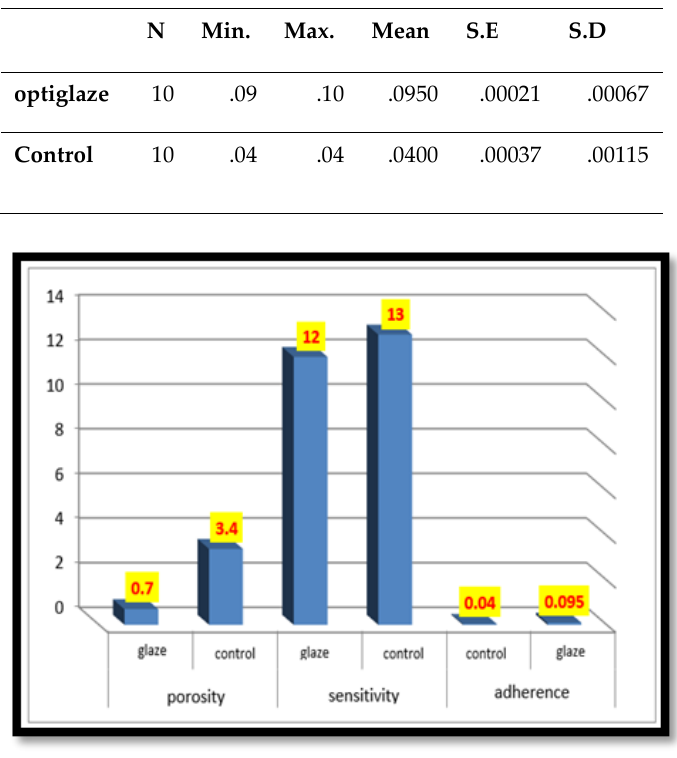
Table 3: Descriptive of adherence Test